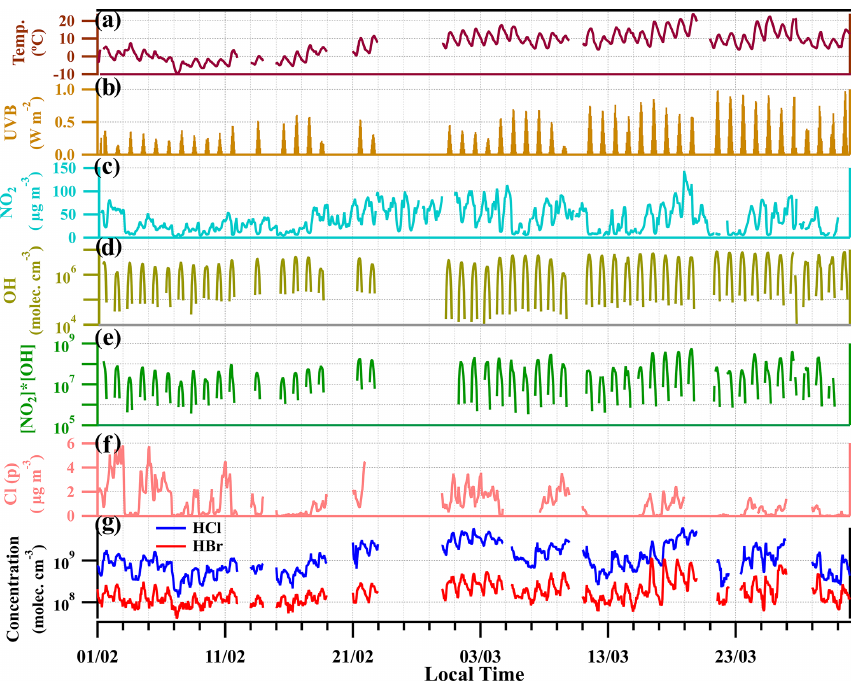
Figure 3. Time profiles of temperature (a) , UVB intensities (b) , NO 2 concentration (c) , OH concentration from calculation (d) , [NO 2 ] × [OH] (µgm − 3 × molecules cm − 3 ) (e) , particulate chloride concentration (Cl( p )) (f) and the mixing ratios of HCl and HBr (g) . The data points are in hourly average